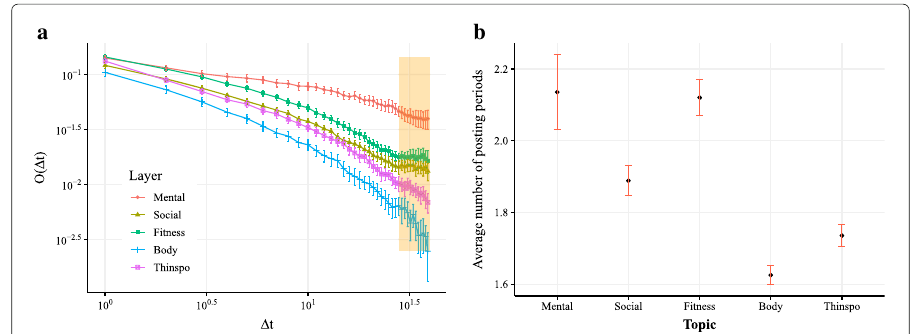
Fig. 6 a Mean overlaps of active users in temporal networks across interval (cid:8) t . Error bars give 95% CI and yellow region highlights the stable stages in the mental , social and fitness layers. b Average numbers of periods that users post content on each topic. Error bars show 95%